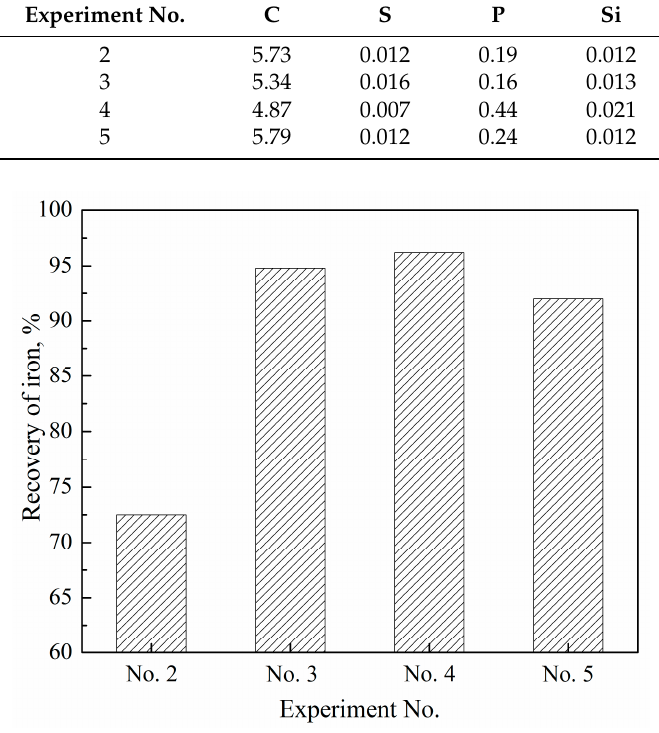
Figure 8. Recovery of iron in the metallic phase after smelting separation.